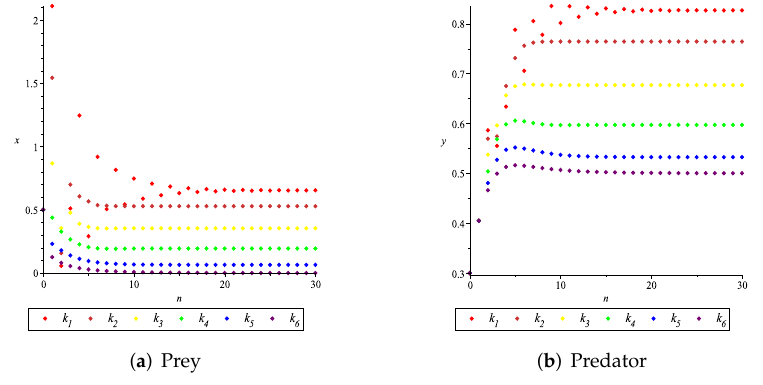
Figure 11. Prey and predator densities at different values of k